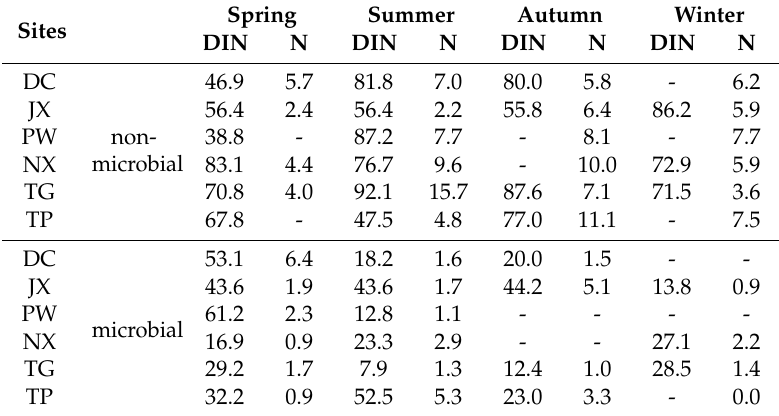
Table 2. Proportion of DIN (dissolved inorganic N) reduction rates and N load attributable to microbial and non-microbial processes